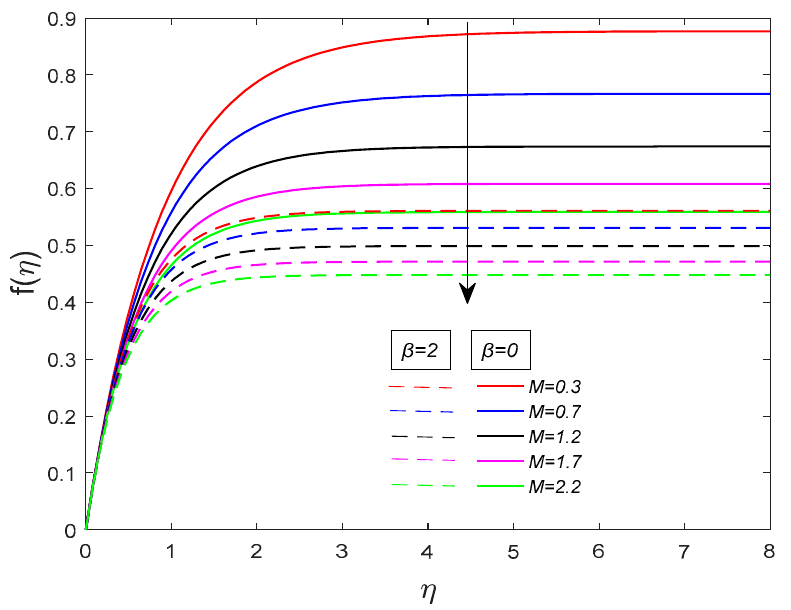
Figure 2. Effect of magnetic parameter (M) on normal velocity profile with Pr = Sc = 0.7, Ec = Kr = Sr = 0.1.